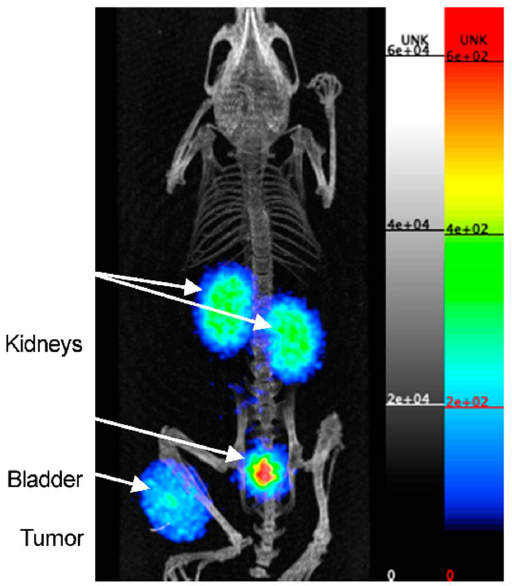
Figure 6. PET/CT image of a mouse bearing a hPD-L1POS tumor at 1 h 20 p.i. of the [ 68 Ga]Ga-NOTA-(hPD-L1) nanobody, obtained on the β-CUBE PET/CT system. Scale on the PET image is in kBq/mL. Adapted with permission from [53].